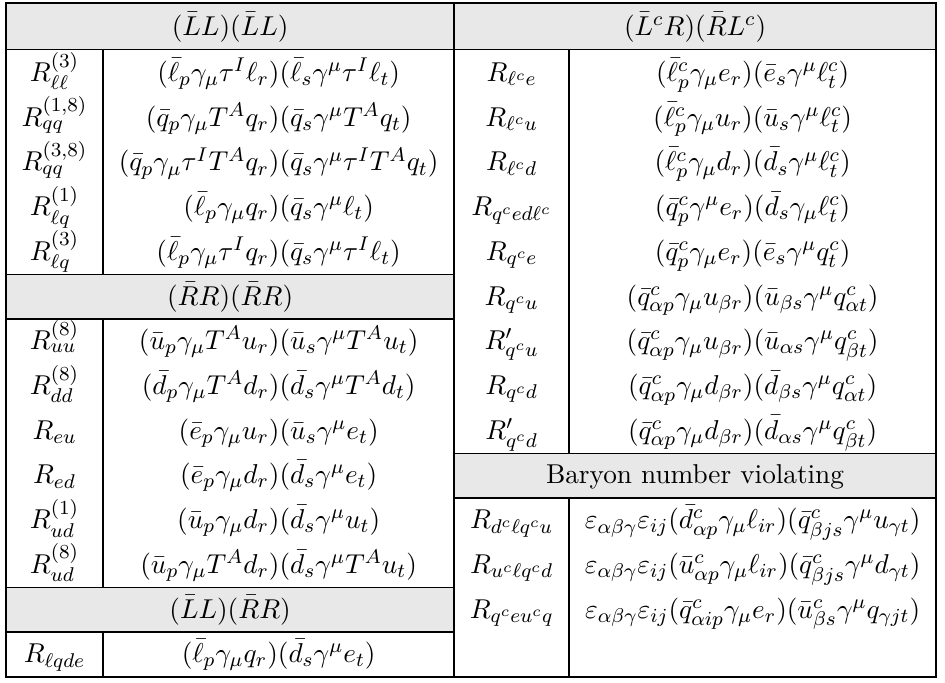
Table 2. Vector-type four-fermion operators that are redundant in d = 4